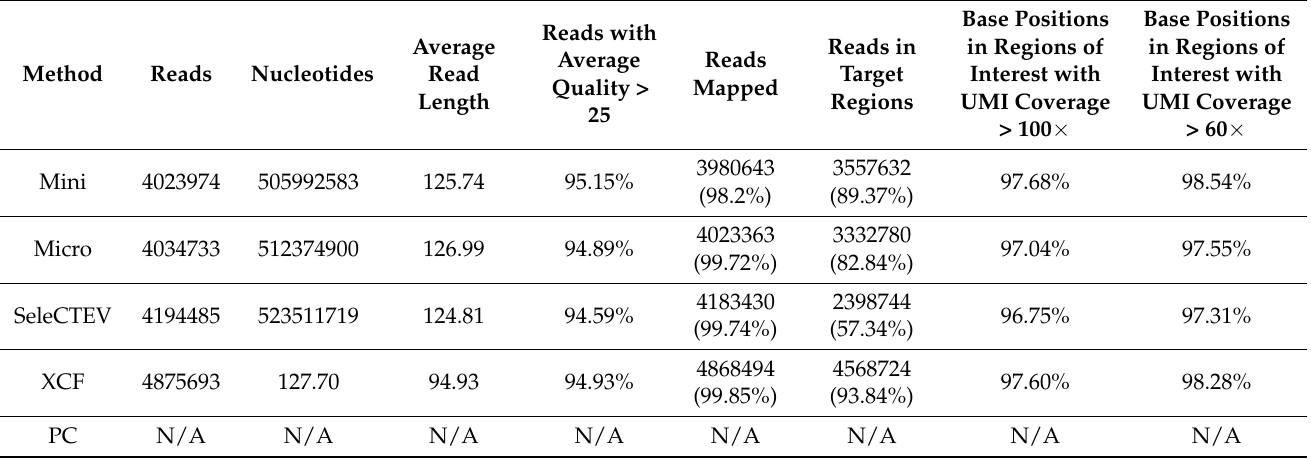
Table 4. Summarized quality parameters of H1975 EV-DNA NGS analysis.